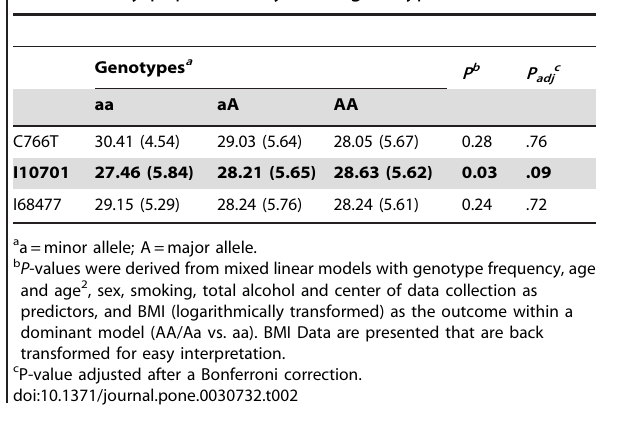
Table 2. BMI (kg/m 2 ; standard deviation) distribution of the GOLDN study population by LRP-1 genotype.